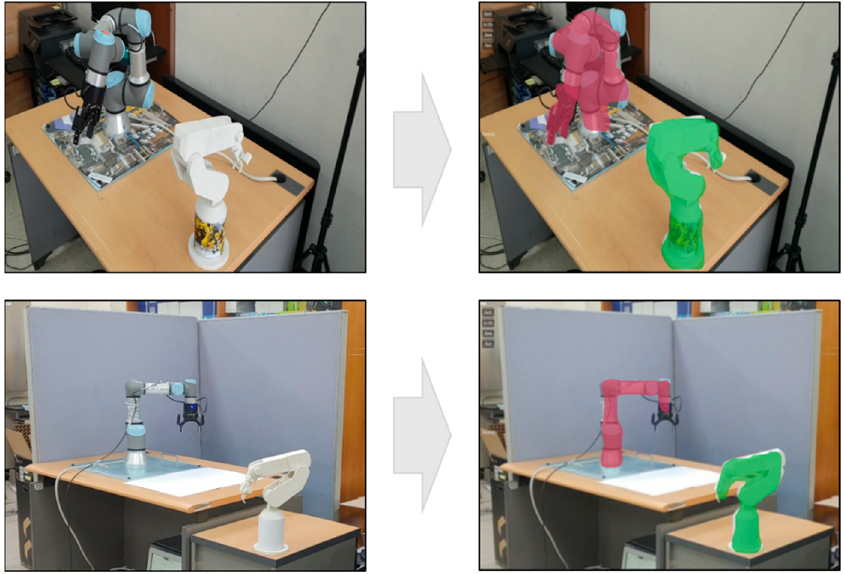
Figure 12. Recognition of physical objects with different distances (depth perception).